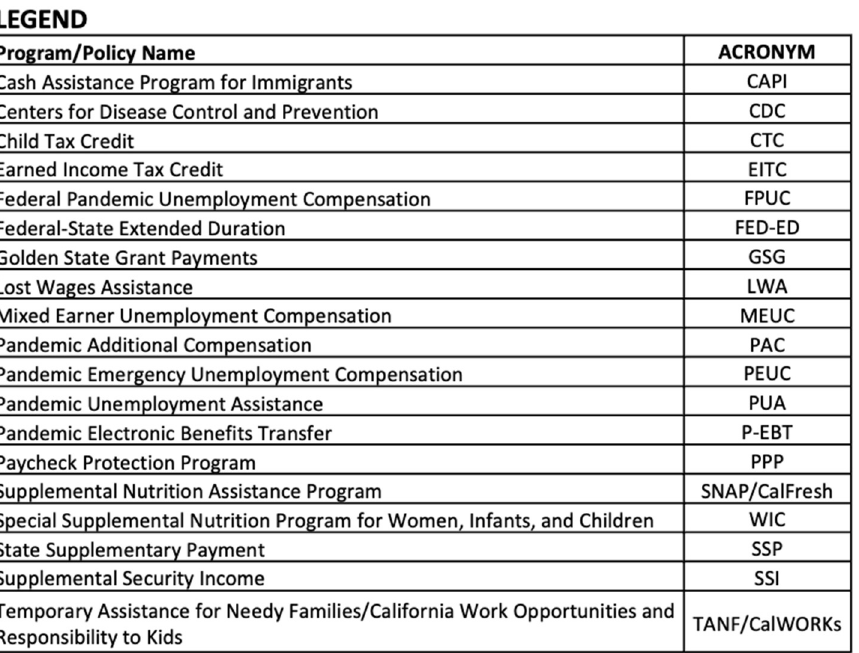
Figure 1. Timeline of California and federal implementation of COVID-19-related programs and policies relevant to vulnerable populations, March 2020 to November 2021.